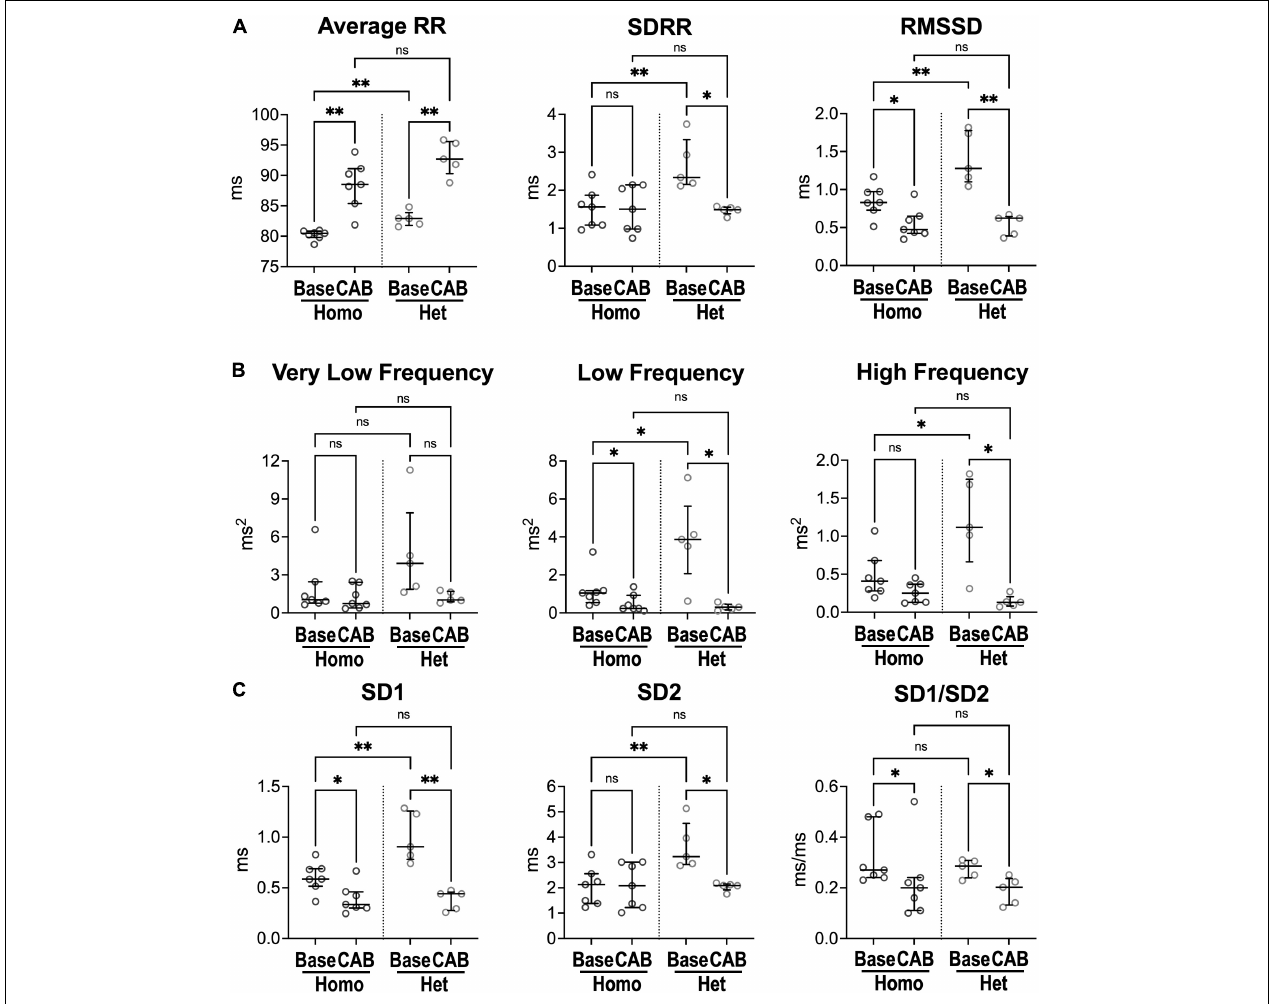
FIGURE 2 | Inhibition of the autonomic nervous system and heart rate dynamics in naïve Homo and Het mice. (A) Quantitative data for RR interval duration and time-domain parameters of HRV for Homo and Het mice before (baseline, Base) and after combined autonomic block with atropine and propranolol (CAB). (B) Data for frequency-domain parameters of HRV. (C) Data for non-linear indices. Quantitative data were obtained from naïve Homo ( n = 7) and Het ( n = 5) female mice. Data are shown as scattered plots with median and interquartile ranges. ns, not significant, ∗ P < 0.05, ∗∗ P < 0.01 using paired t -test or Wilcoxon signed rank test for comparisons within each genotype and unpaired t -test or Mann-Whitney test for comparisons across